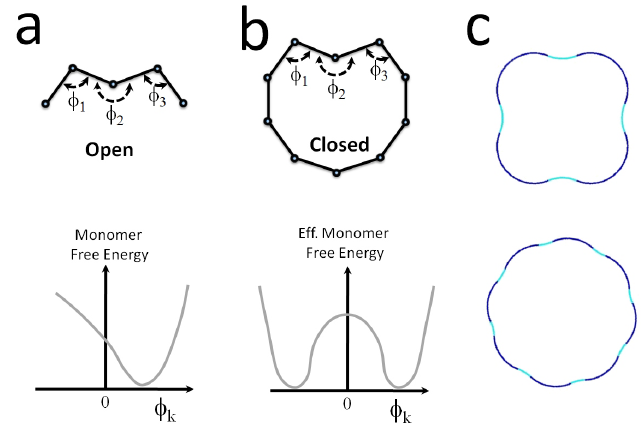
Figure 12. Polymorphic crunching: ( a ) Nonlinear bendable units are coupled in-plane of bending by a ring closure constraint ( b ). The constraint modifies their effective free energy and gives rise to a bistable monomer potential. ( c ) Two out of exponentially many energetically-equivalent ground state realizations. Blue and light-blue indicate the regions of opposite